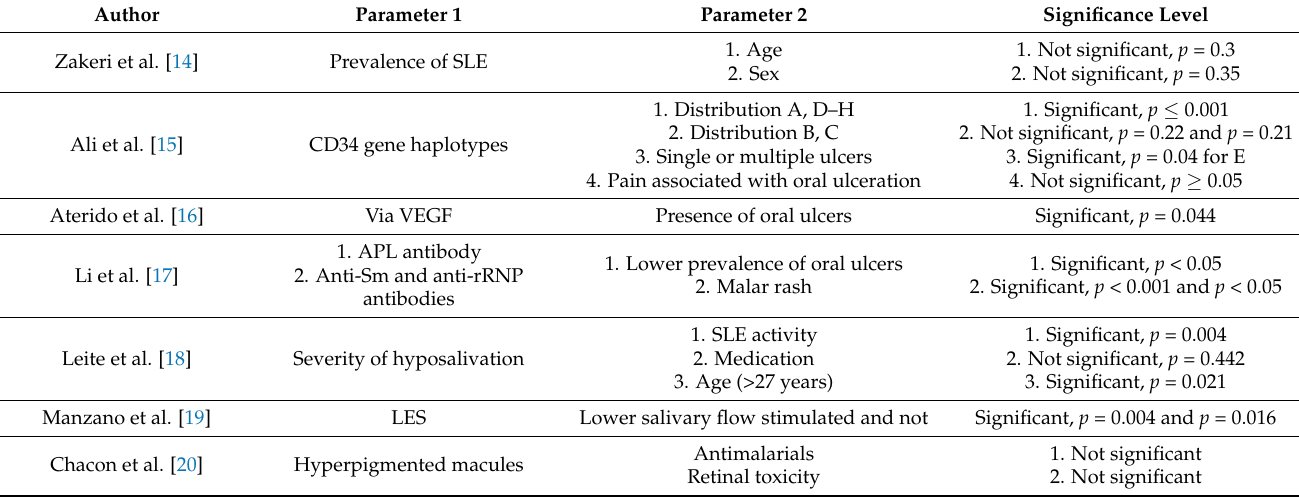
Table 3. Oral signs and symptoms and their significant